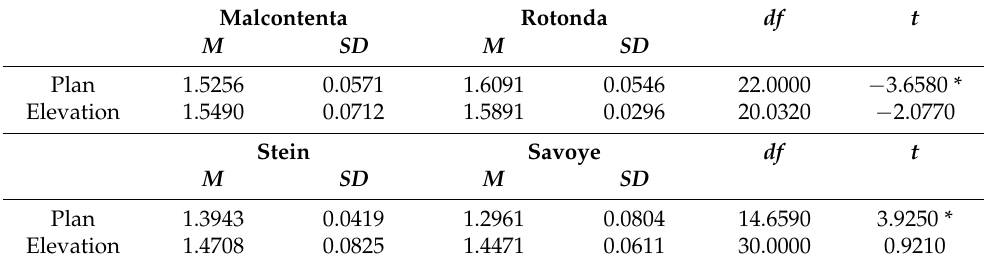
Table 5. t -test results for